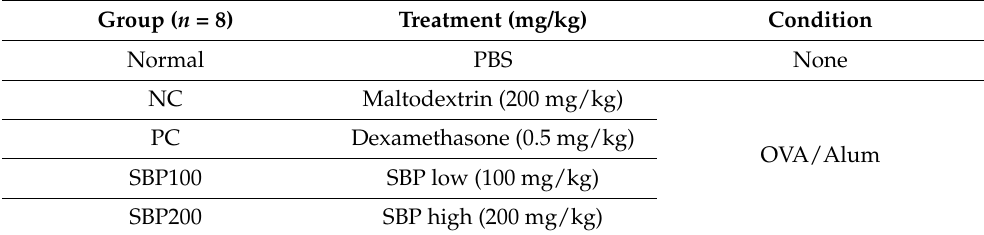
Table 2. Animal experimental groups and treatments. Group ( n =